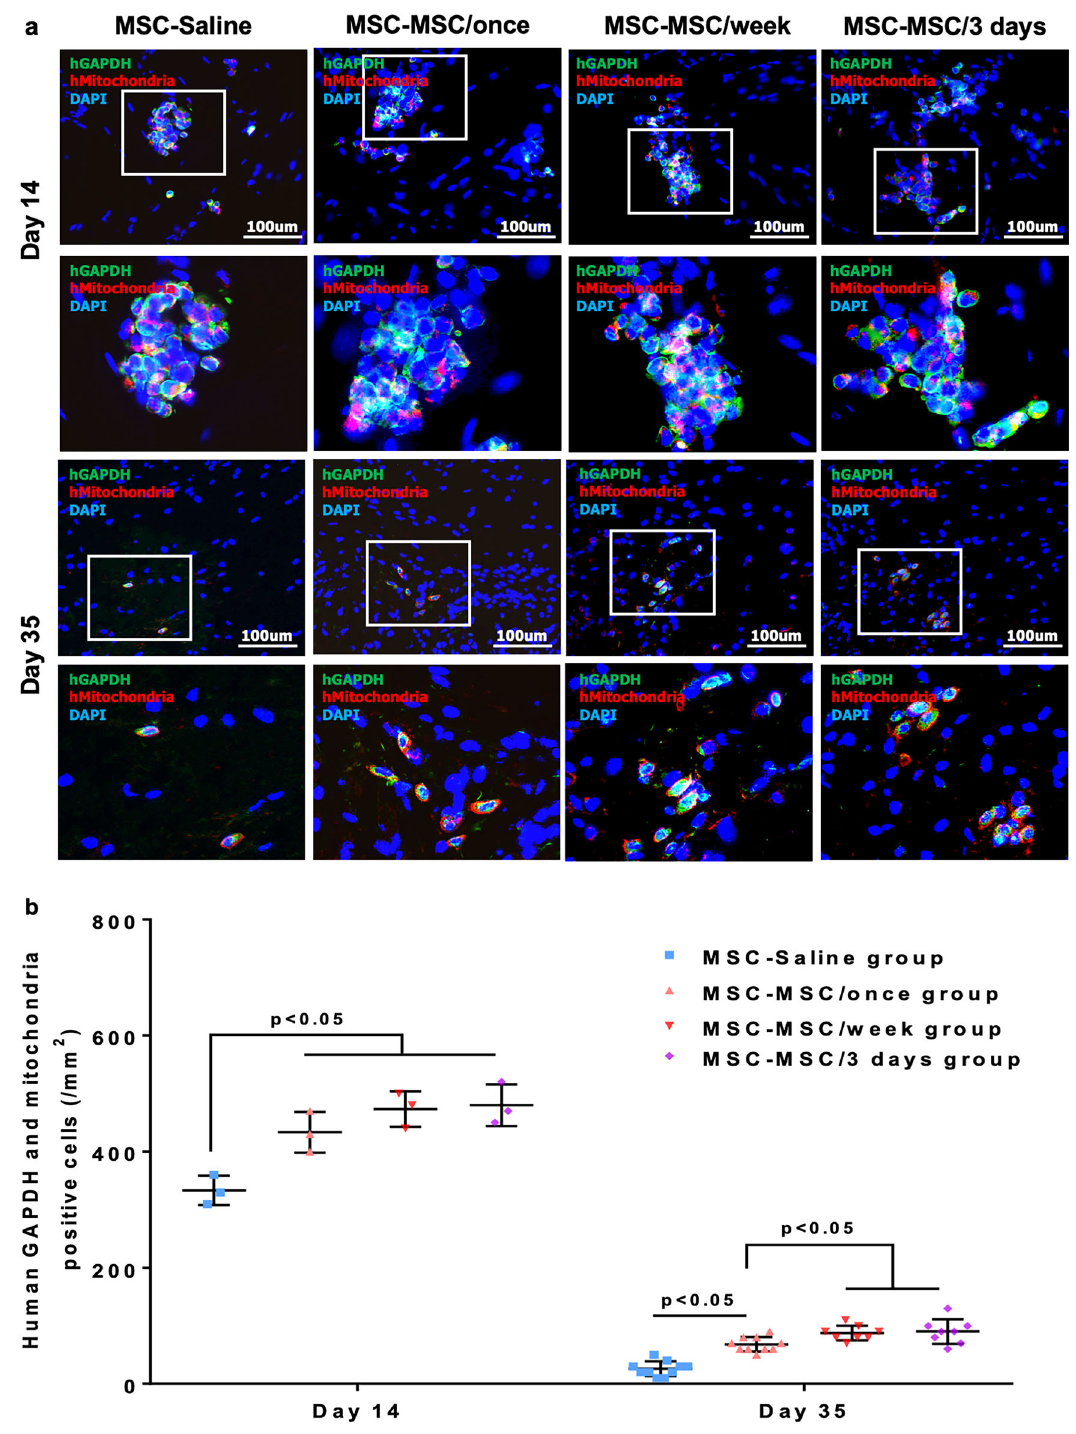
Fig. 6 Repeated intravenous administration of hiPSC-MSCs improved the engraftment of transplanted hiPSC-MSCs in ischemic tissue. The engraftment of intramuscularly transplanted hiPSC-MSCs was further con fi rmed by double immunohistochemical staining with anti-human GAPDH (green) and anti-human mitochondria antibodies (red) at day 14 and 35 ( a ). A single or repeated intravenous hiPSC-MSC infusion in the MSC-MSC/once, MSC-MSC/week and MSC-MSC/3 days groups signi fi cantly improved the engraftment of intramuscularly transplanted hiPSC-MSCs from day 14 onwards (all p < 0.05). Repeated intravenous hiPSC-MSC infusion in the MSC-MSC/week and MSC-MSC/3 days groups further improved the engraftment of intramuscular transplanted hiPSC-MSCs at day 35 compared with the MSC-MSC/once group (all p < 0.05), whereas no signi fi cant difference was observed between the MSC-MSC/week and MSC-MSC/3 days groups ( p > 0.05) ( b